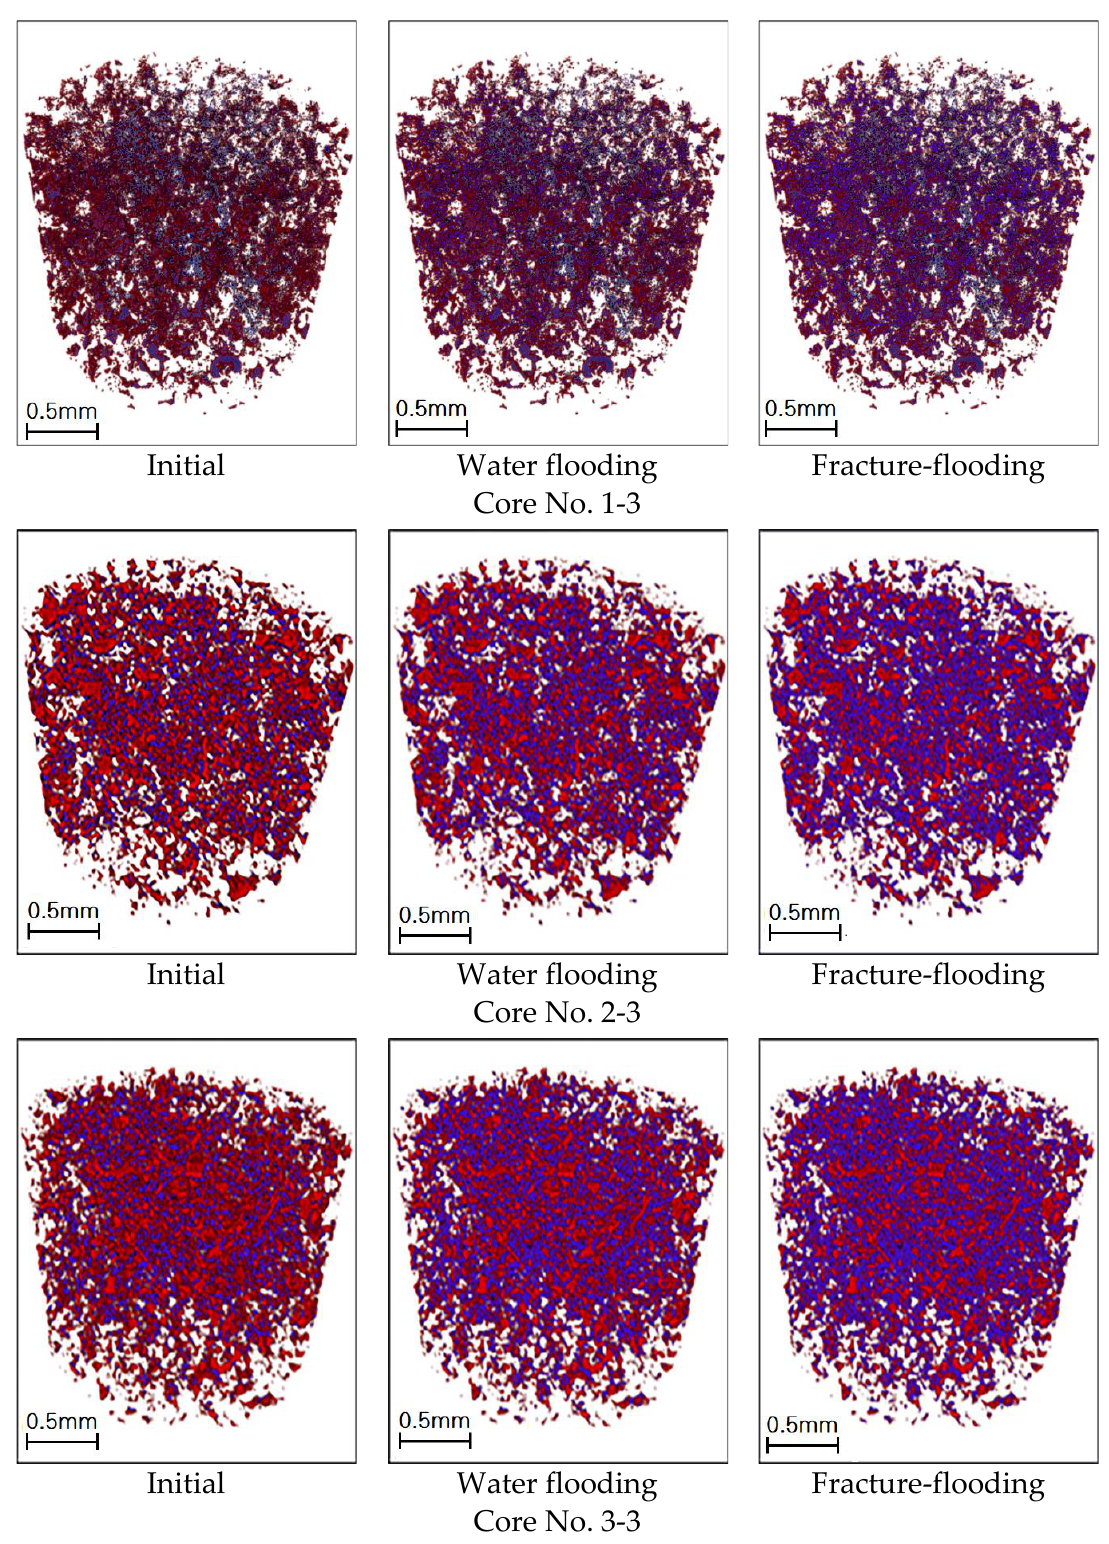
Figure 15. Three-dimensional distribution map of remaining oil constructed after CT